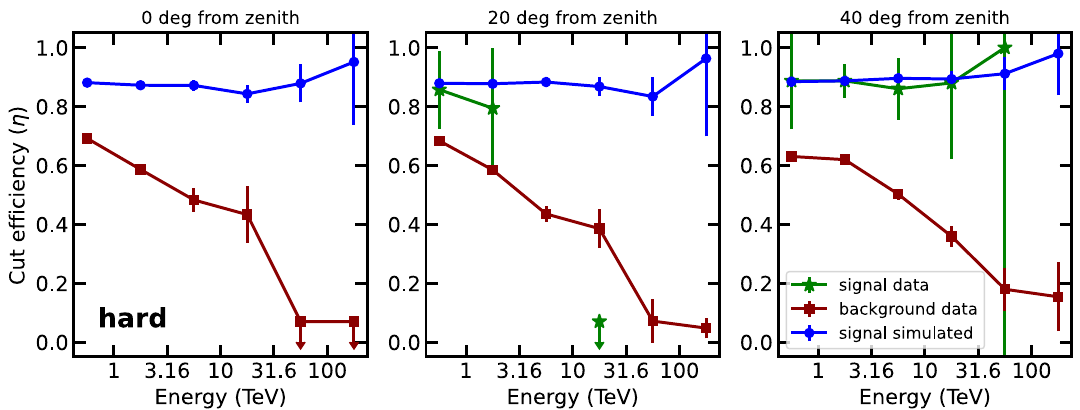
Fig. 4 Fraction of events kept by the ABRIR cut applied after the H.E.S.S. hard cuts. Meaning of different panels and colors is the same as in Fig. 3. When zero events survive the cut, the 68% containment limit is drawn assuming Poissonian